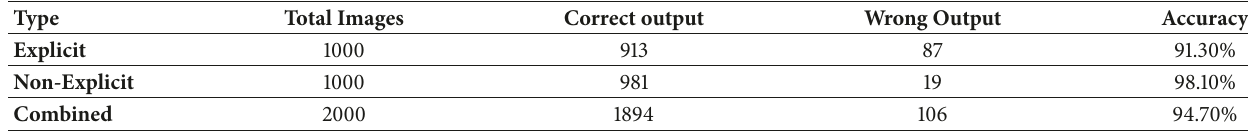
Table 2: Statistical analysis of explicit, nonexplicit, and combined image dataset.